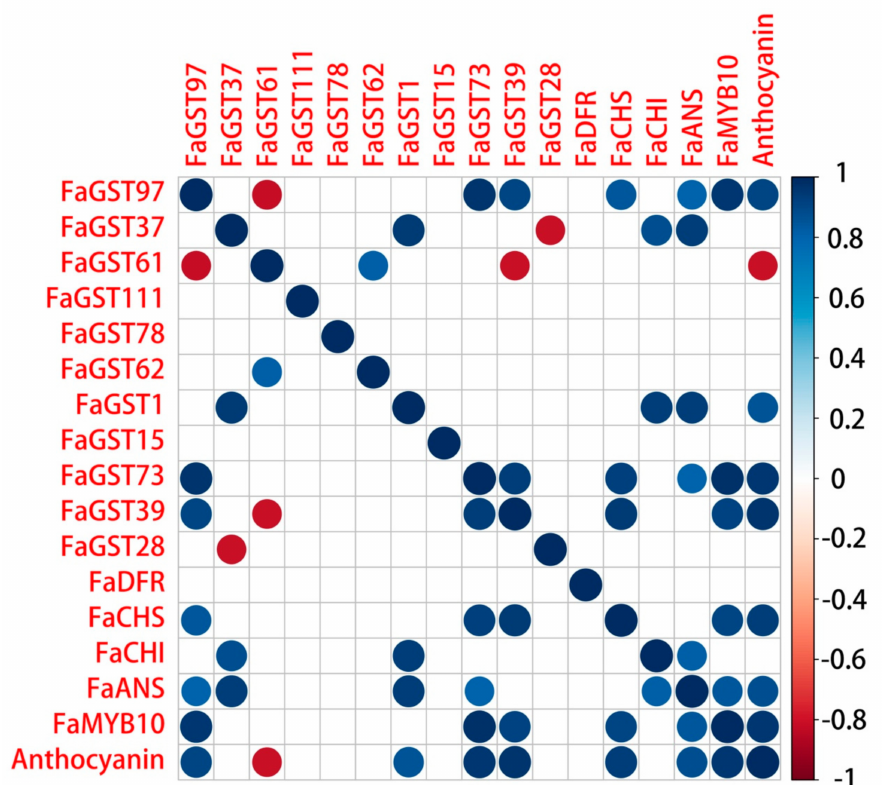
Figure 8. The correlation analysis of selected putative anthocyanin-related FaGST genes, anthocyanin biosynthetic / regulatory genes, and anthocyanin content. Dots indicate the significant correlation (Pearson test, p -value < 0.05), blank indicates the insignificant correlation. Color from red to blue indicates the correlation coe ffi cient ranging from − 1 to 1.